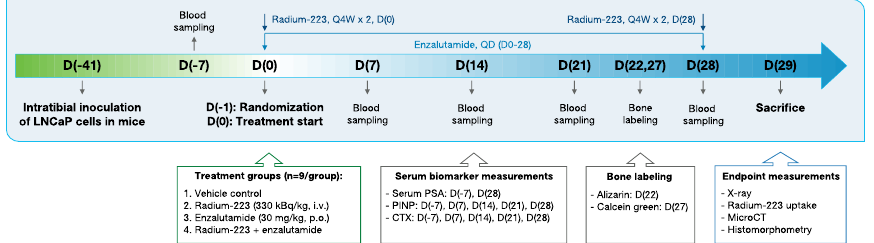
Figure 7. The study outline and timeline of the intratibial LNCaP model. Six weeks after inoculation, the mice were stratified to treatment groups and treated with vehicle, radium-223 (330 kBq/kg, Q4W × 2, i.v., on days 0 and 28), enzalutamide (30 mg/kg, QD × 28, p.o.), or a combination of radium-223 and enzalutamide for 28 days. D(number) indicates days from treatment start.